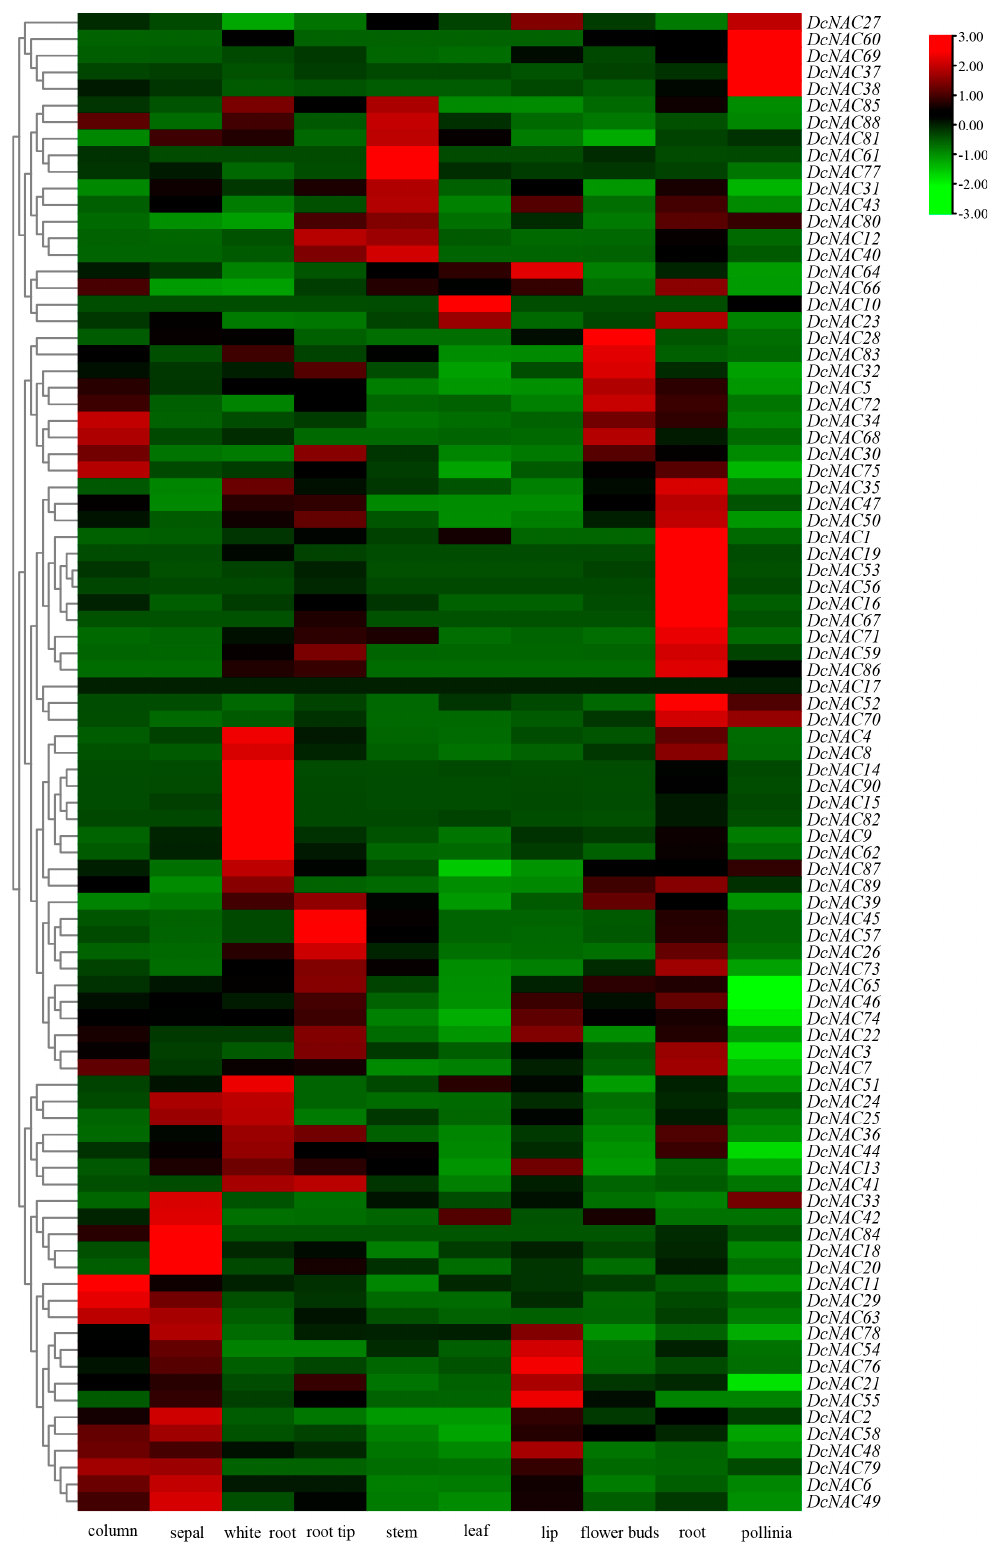
Figure 5. Hierarchical clustering of expression profiles of DcNAC gene expression profiles across different D. catenatum tissues. Data were normalized relative to each gene’s mean expression value across all tissues and log2-transformed. TPM (transcripts per million) values were used to create heat maps showing the expression of DcNAC genes in different tissues, ranging from low expression (green) to high expression